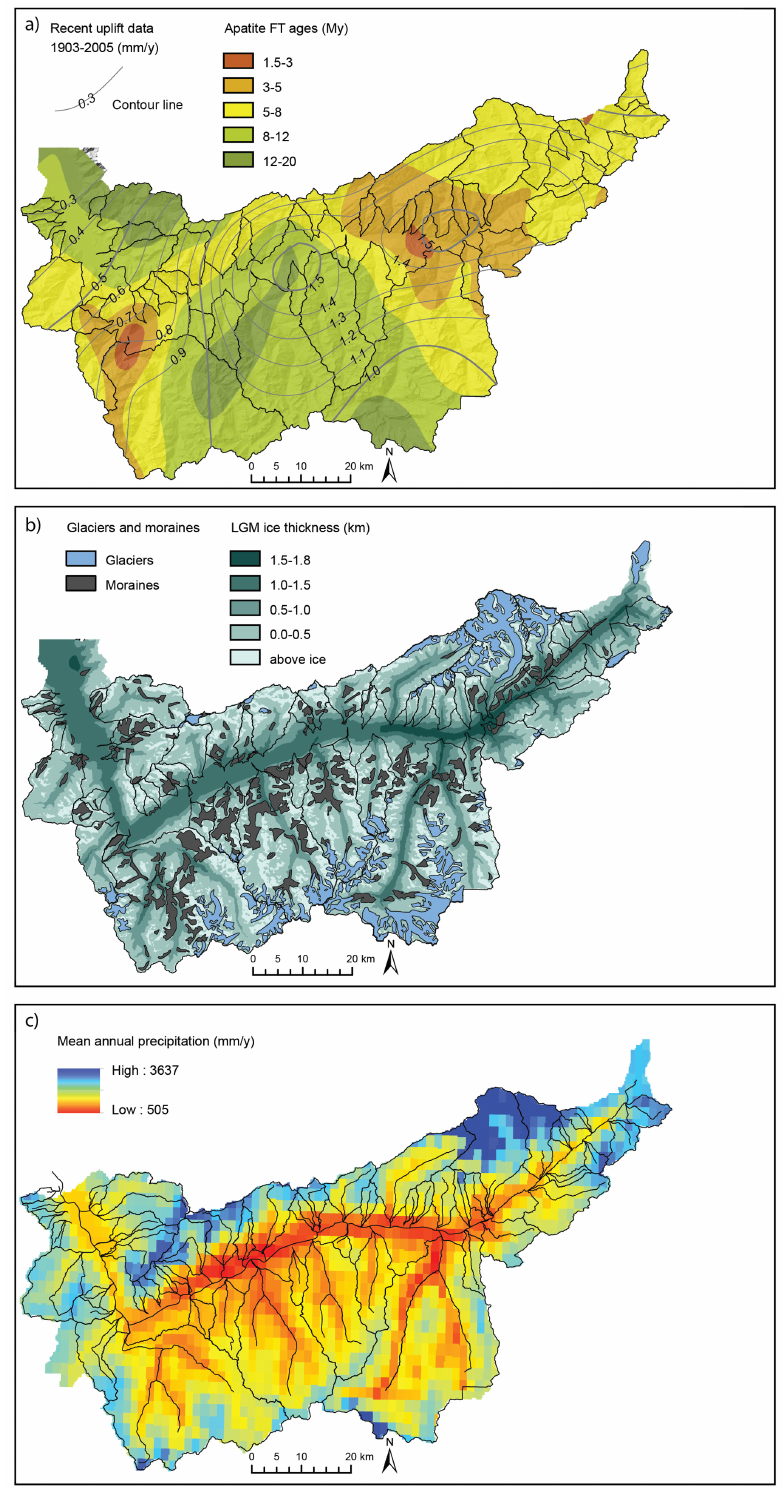
Figure 3. Panel (a) : interpolated exhumation ages based on apatite fission-track dating (Vernon et al., 2008) show youngest ages both in the east and the west and a decrease towards the basin outlet at Lake Geneva. Contour lines indicating recent uplift (for the time span 1903– 2003) are interpolated from Schlatter et al. (2005) and Kahle et al. (1997). Panel (b) : map showing the ice thickness during the Last Glacial Maximum (from Bini et al., 2009) and the recent distribution of moraine deposits (glacial till) and glaciers. Panel (c) : spatial distribution of total annual precipitation averaged over the period 1961–2012 based on Schwarb